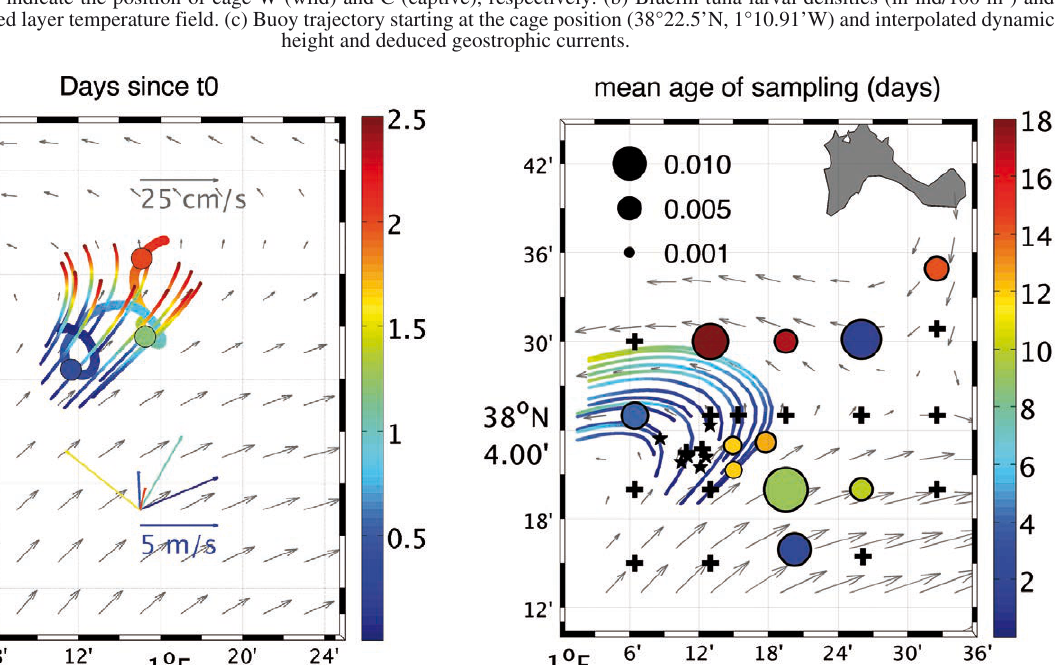
Fig . 3. – Hydrographical and biological data. (a) Biological sampling stations (crosses) and interpolated mixed-layer salinity field. The blue and the red stars indicate the position of cage W (wild) and C (captive), respectively. (b) Bluefin tuna larval densities (in ind/100 m 3 ) and